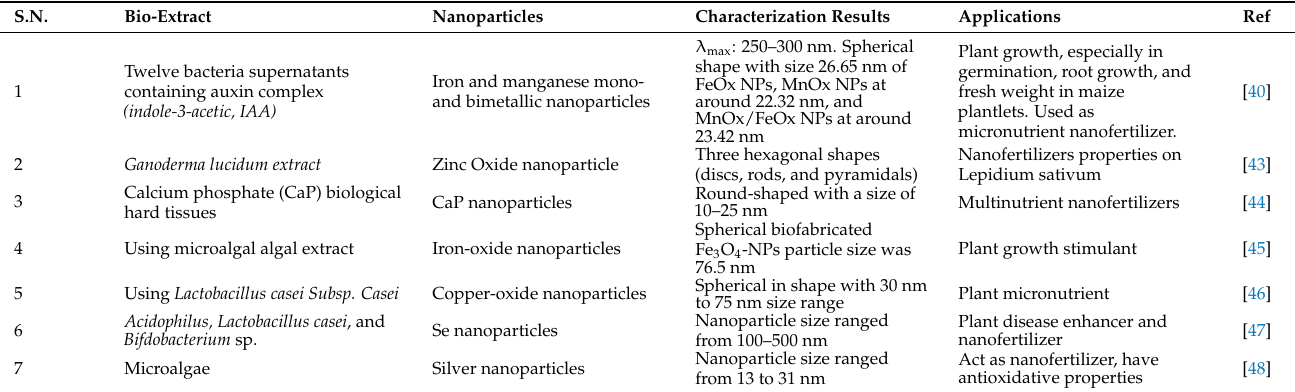
Table 1. Green synthesis of nanofertilizers using different